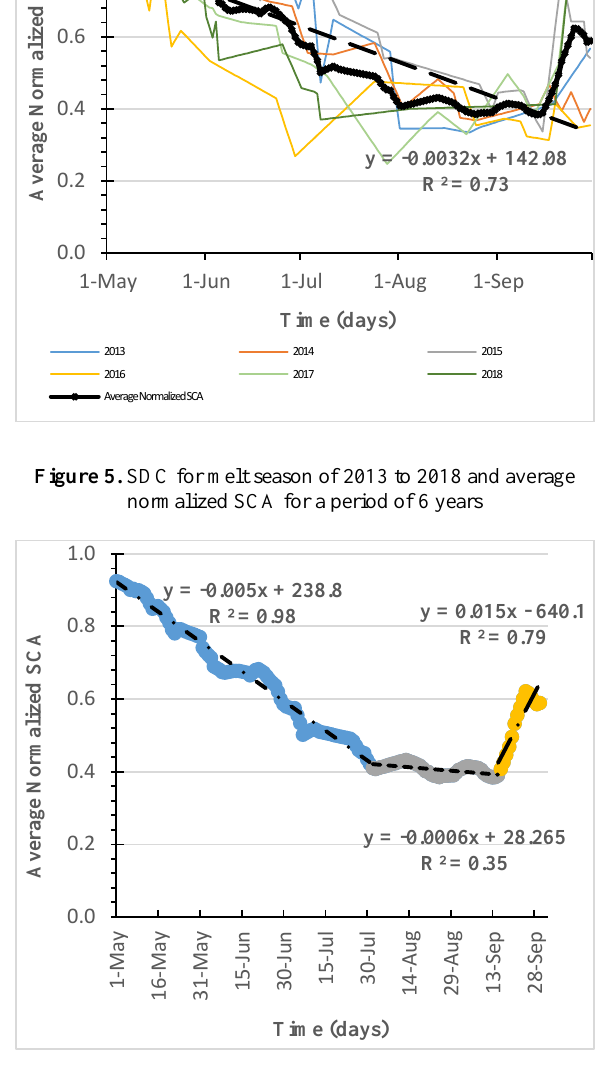
Figure 6. Division of average SDC in three parts for entire snowmelt